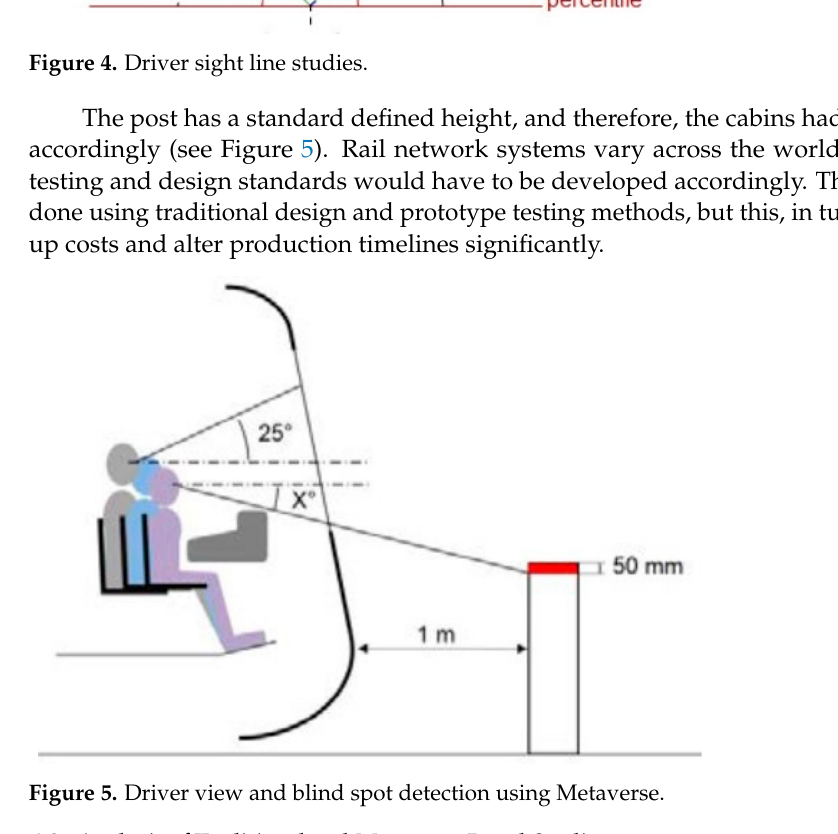
( b ) Figure 6. Change in frontal view: ( a ) initial design, and ( b ) final design. Figures 7a,b and 8 show a comparative benchmarking study. The Metaverse-based simulations for prototyping were compared with the traditional prototype manufacturing